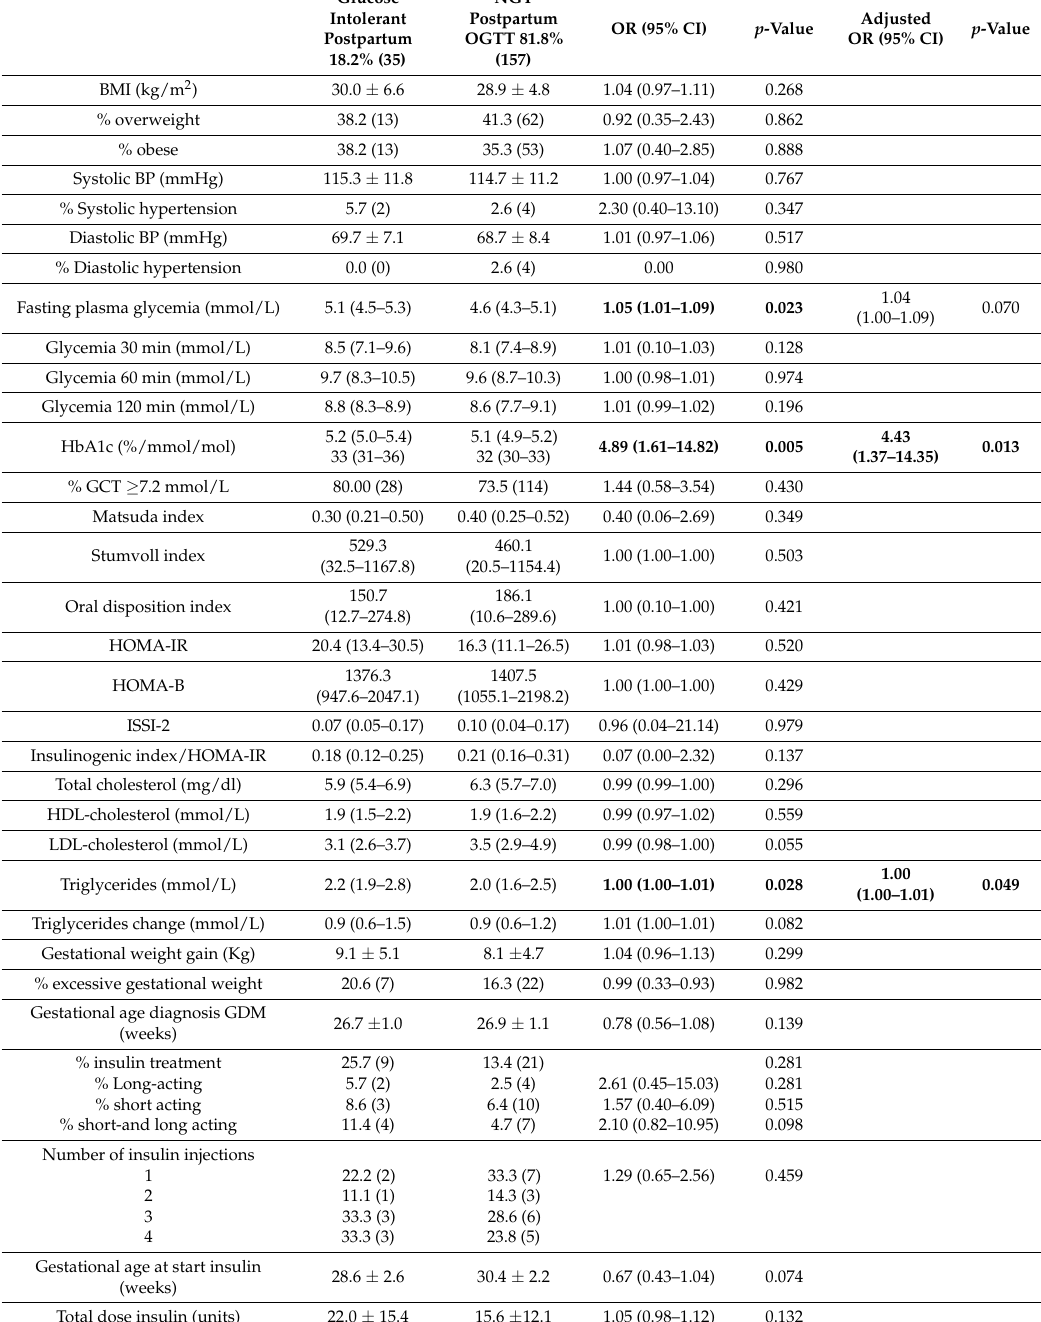
Table 4. Predictors of glucose intolerance postpartum based on clinical and biochemical risk factors 24–28 weeks of